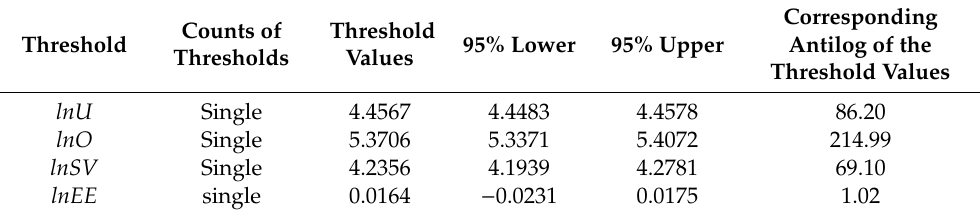
Table 7. Threshold results for each threshold variable.